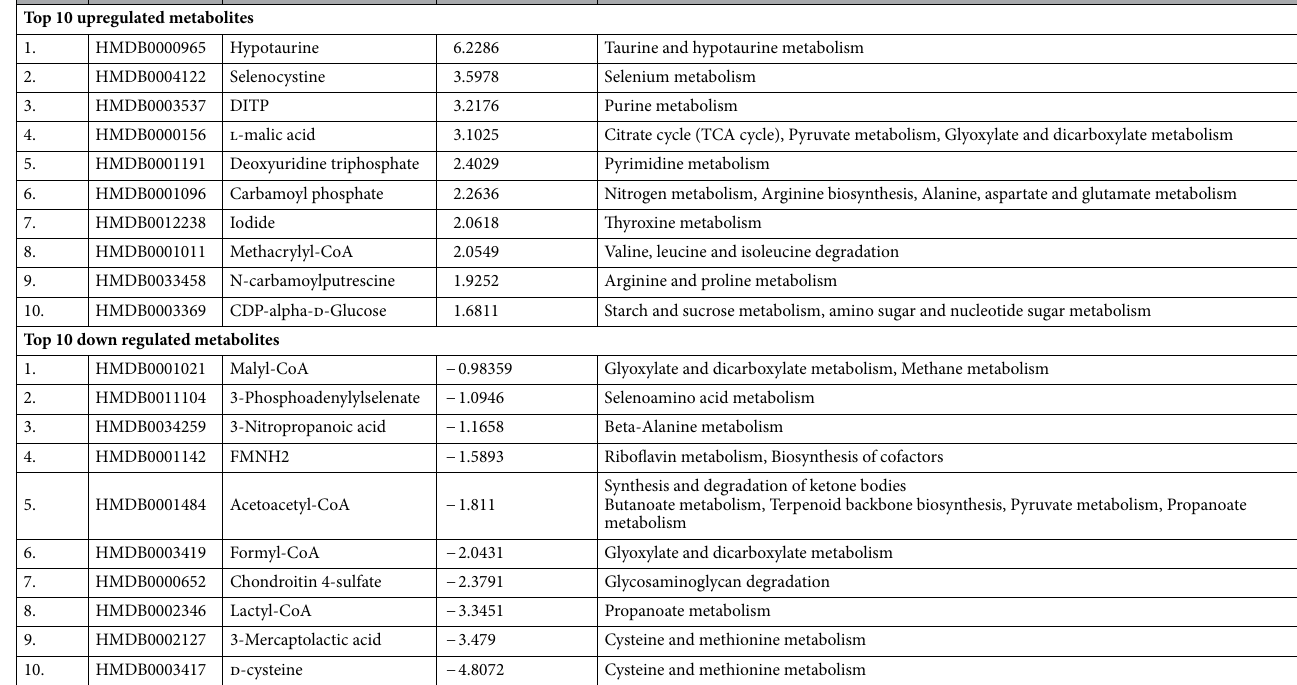
Table 3. Top 10 upregulated and down regulated metabolites in low-fertility bulls.